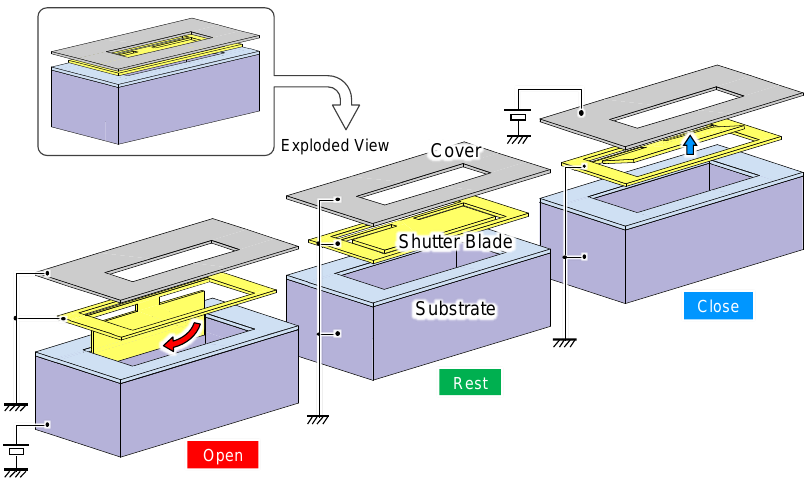
Figure 3. Exploded views of the electrostatic mechanism of micro shutter element. From left to right: open position (shutter blade retracted inward), rest (shutter blade at horizontal position), and close (shutter blade latched upward to the cover). The cover and the substrates are used to attract the shutter blade by the electrostatic force of the applied voltages.